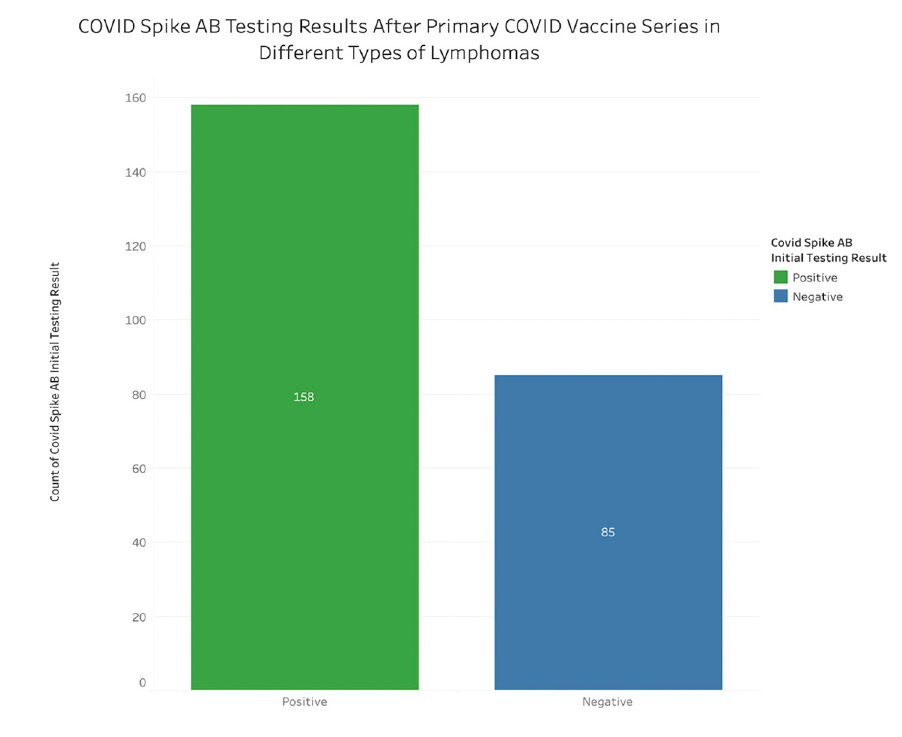
Fig 1. Serologic response against COVID spike protein after primary vaccination series in the overall population.